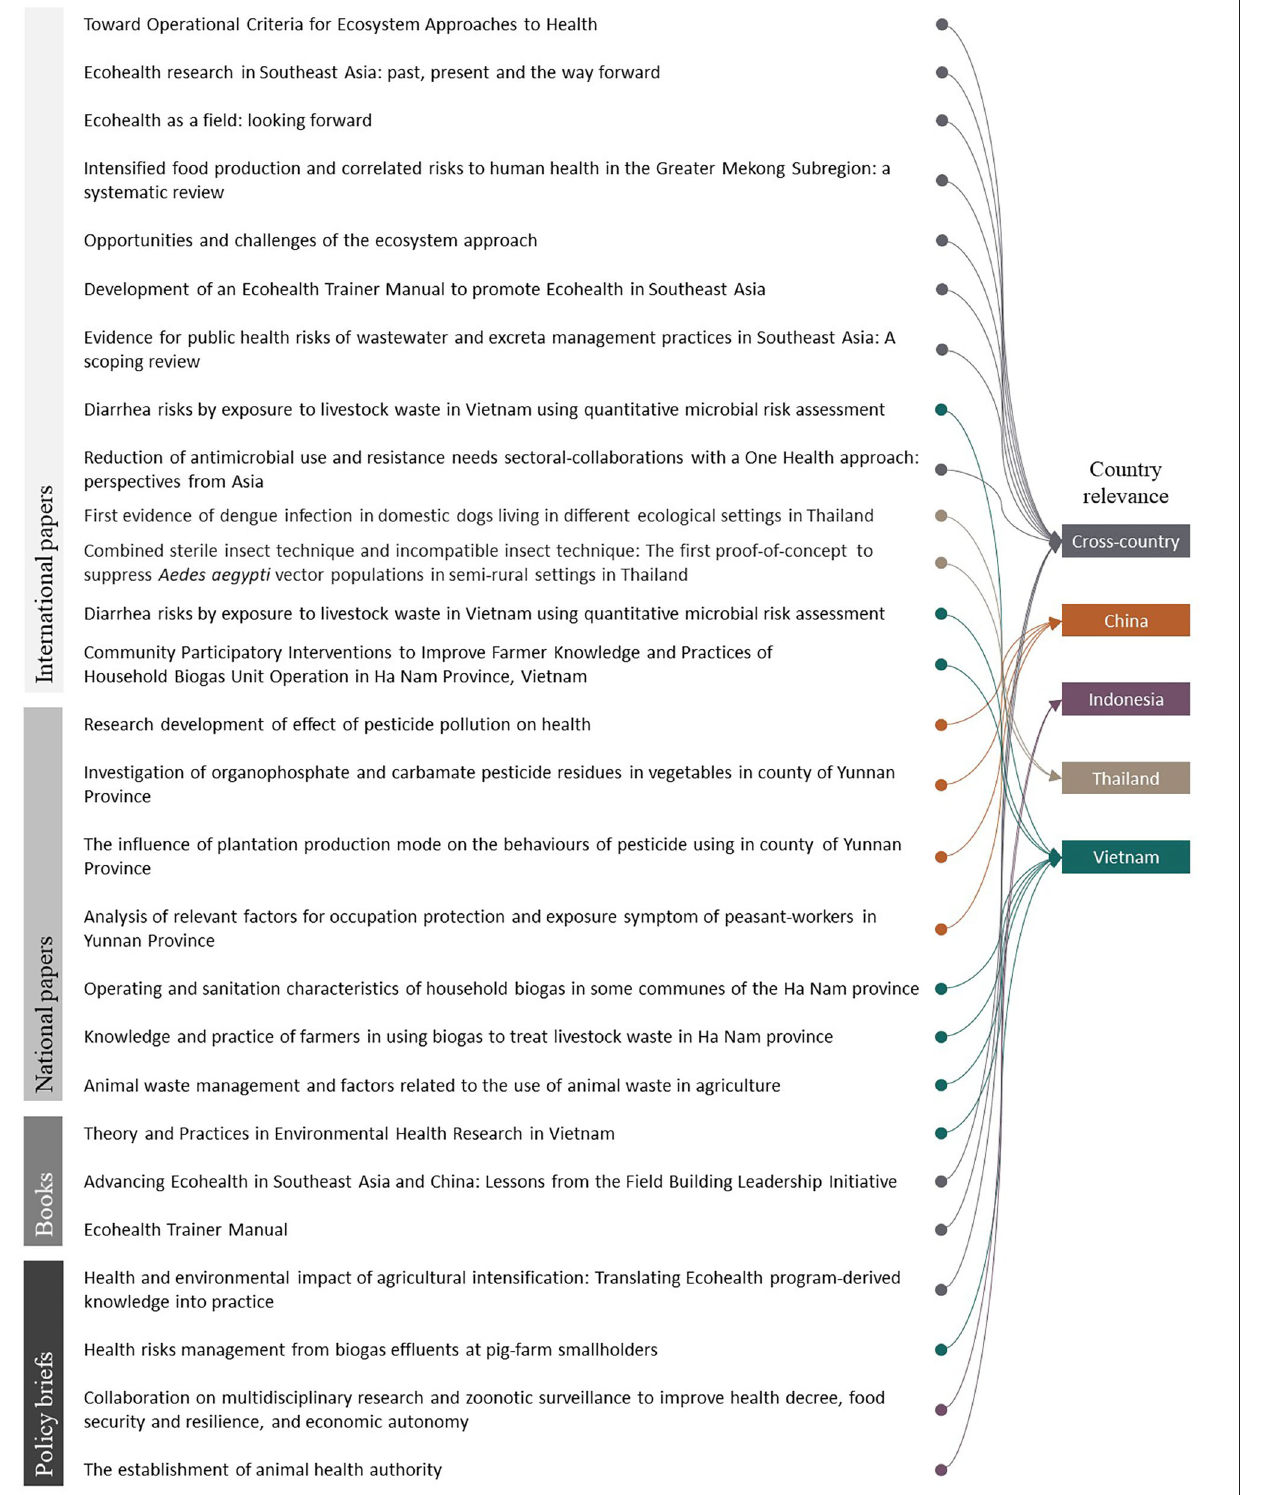
Frontiers in Public Health |